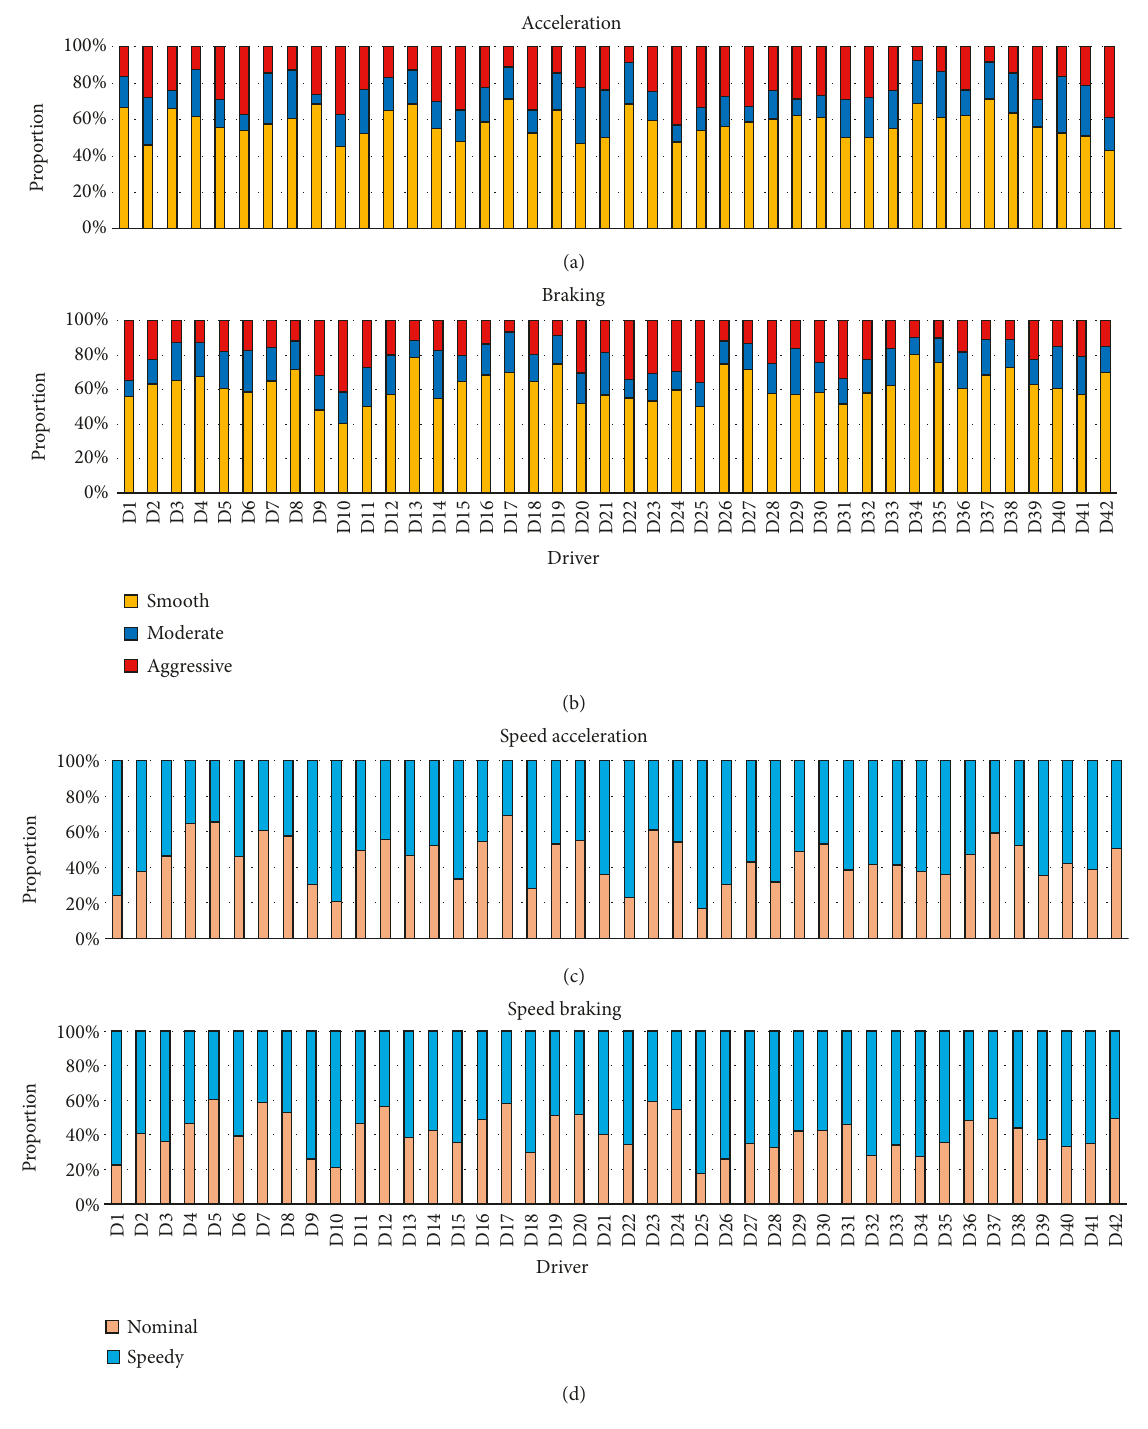
Figure 9: The proportion of (a) acceleration patterns; (b) braking patterns; (c) and (d) speed patterns for